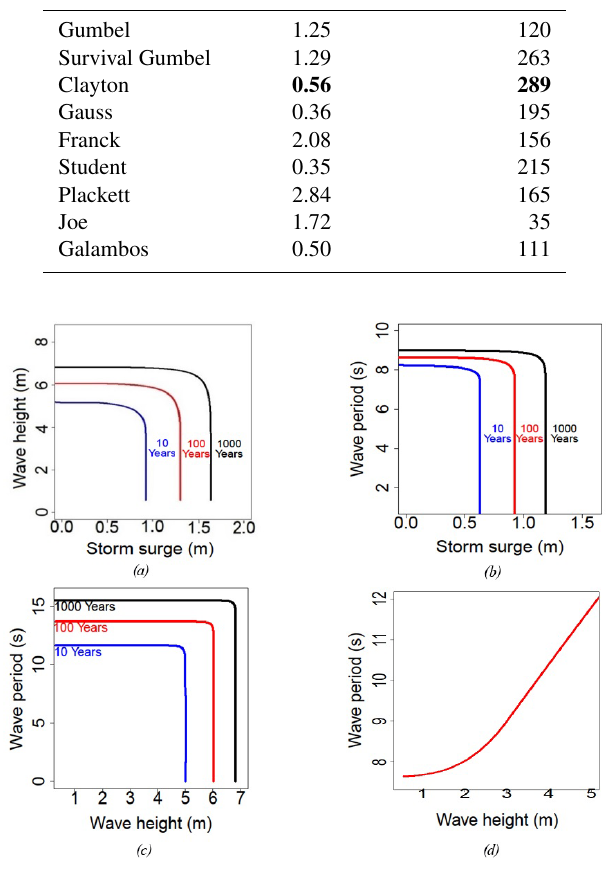
Figure 10. Contours of equal joint exceedance probability with a trivariate copula.